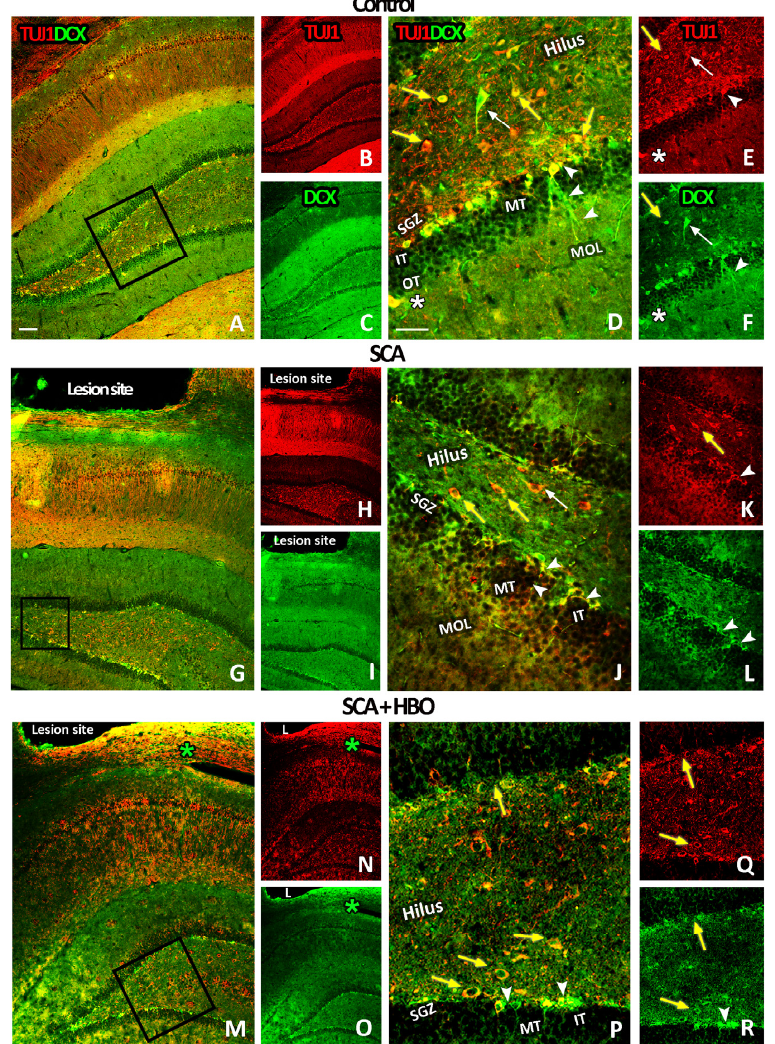
Figure 5. DCX (doublecortin) and TUJ1 (beta-III tubulin) immunoreactivity in the hippocampal DG (dentate gyrus) of control, SCA (suction cortical ablation), and HBO (hyperbaric oxygenation)-treated SCA animals. DCX (green) and TUJ1 (red) staining were used to visualize newborn neurons in the brain sections from controls ( A – F ), animals undergoing SCA ( G – L ), and HBOT (hyperbaric oxygen therapy) ( M – R ). ( D – F ) Higher magnification images of control sections revealed DCX/TUJ1- positive cells in the SGZ (subgranular zone), IT (inner-third) of the GCL (granule cell layer), with dendrites extending toward the MT (mid-) and OT (outer-third) of the GCL (arrowheads). A few DCX/TUJ1 ‐ positive cells were located in the OT of the GCL and molecular cell layer (MOL) (white asterisks). In the hilus, we detected some intensely stained DCX/TUJ1 ‐ positive cells with large cell bodies (white arrows) and others with round/oval morphology (yellow arrows) that were mostly TUJ1 ‐ positive. ( J – L ) Higher magnification indicates that SCA reduced the number of DCX/TUJ1 ‐ positive immature neurons in the SGZ compared to control sections ( D – F ). ( M – O ) After HBOT, concentrated DCX/TUJ1 immunoreactivity is seen around the lesion site (green asterisks), ( P –R) in the SGZ (arrowheads) and in the hilus (yellow arrows) as well. Rectangles indicate where the high ‐ magnification images are taken from. C—control; SCA—sensorimotor cortex ablation. SCA + HBO—SCA animals treated with hyperbaric oxygen. Scale bars: A , G , M —100 μ m; D , J , P —50 μ m.